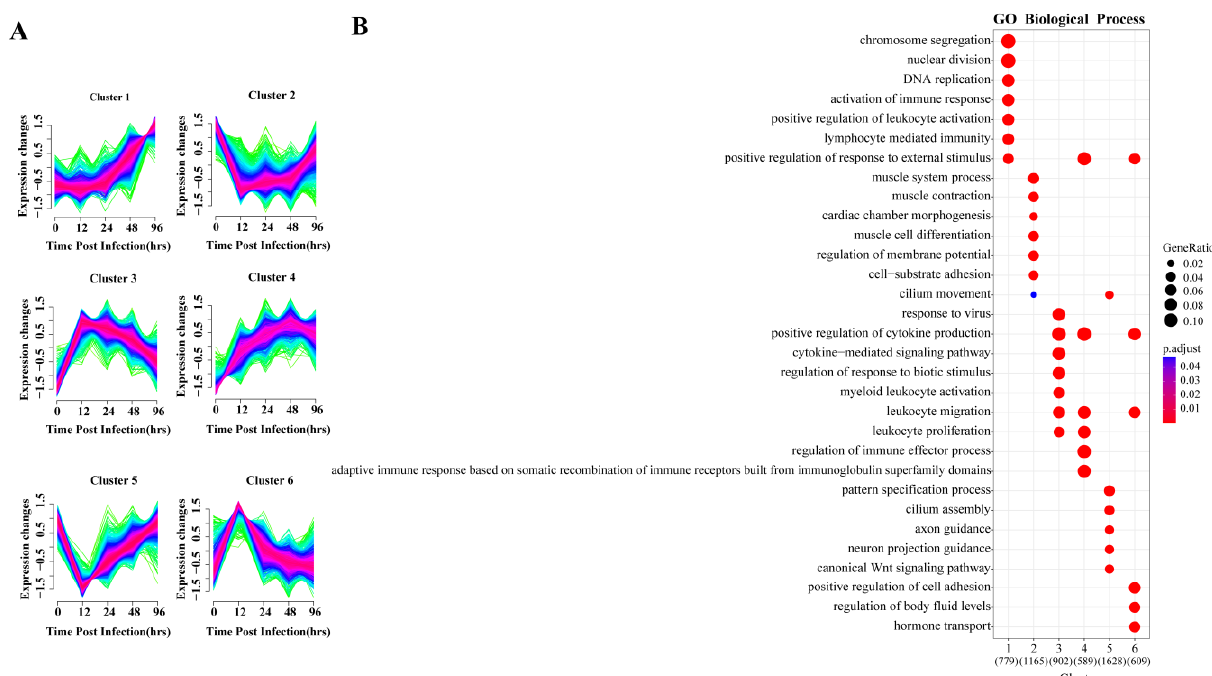
Figure 3. Cluster analysis of expression patterns of DEGS and related biological functions. ( A ) Mfuzz cluster analysis identified six different gene expression time patterns. The color varying gradually from green to red represents that the trends of genes become more suitable to the changes of the cluster. ( B ) Heat map showing the significance of the gene ontology (GO) terms in the biological processes describing each of the six clusters. The number of enriched genes belonging to each cluster is shown in parentheses.